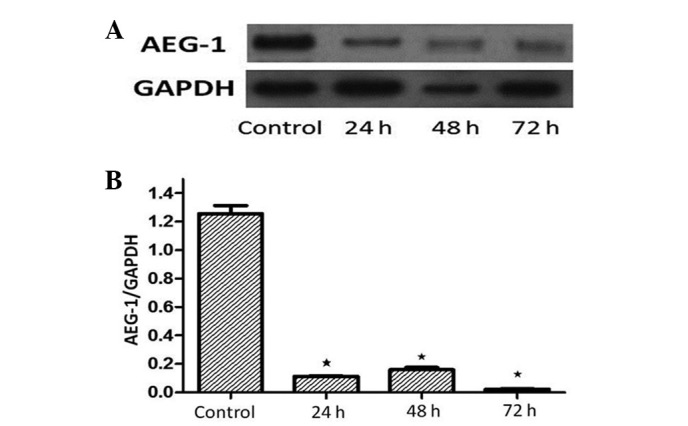
Representative western blotting for AEG-1 protein expression shows downregulation of AEG-1 by siRNA. Data are presented as the means ± standard deviation of three independent experiments. *P<0.05 vs. scramble siRNA (control). AEG-1, astrocyte elevated gene-1; GAPDH, glyceraldehyde-3-phosphate dehydrogenase.